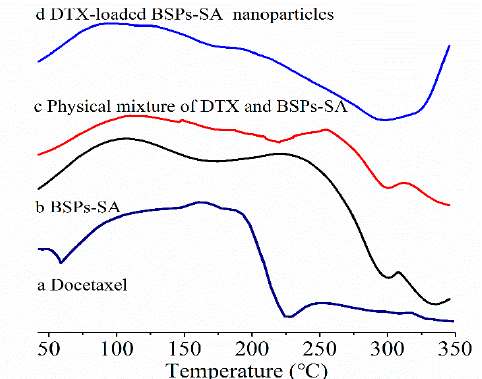
Figure 6. Differential scanning calorimetric curves (a: docetaxel, b: BSPs-SA, c: physical mixture of